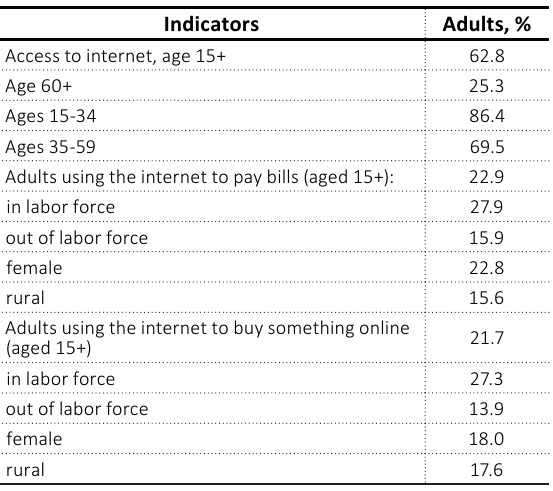
Table 3. Indicators of access to and use of the Internet by the Ukrainian population in